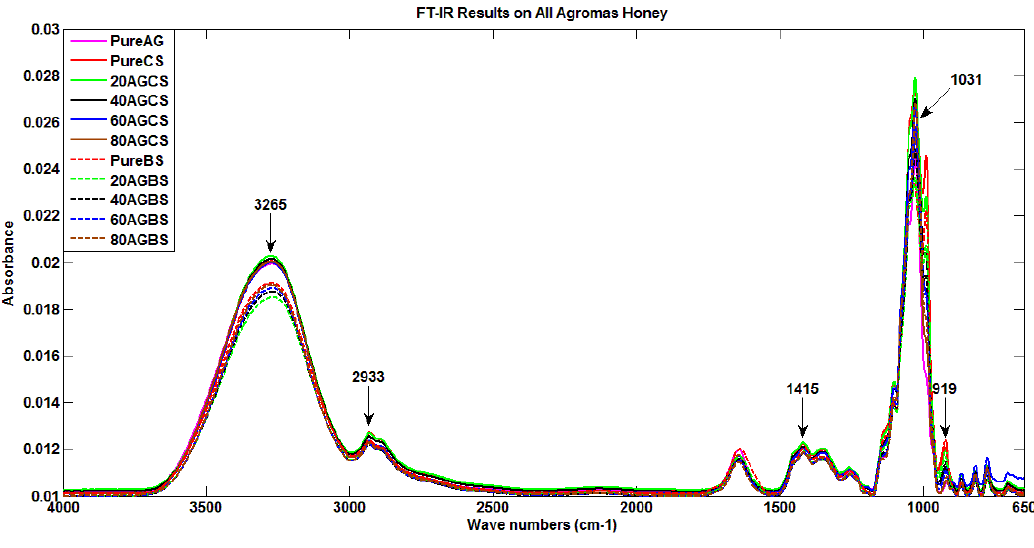
Figure 3. All Agromas honey brand sample with the corrected peak